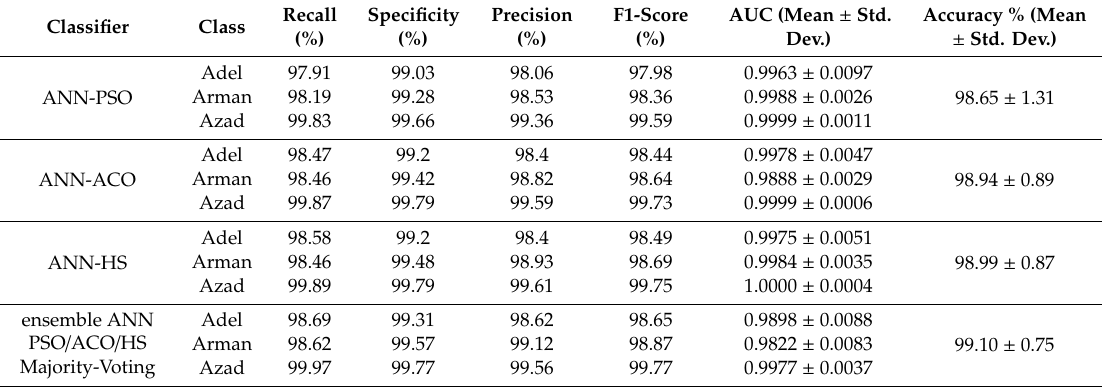
Table 9. Comparison of the performance of the four classifiers (ANN-PSO, ANN-ACO, ANN-HS and ensemble ANN PSO / ACO / HS-MV): recall, specificity, precision, f1-score, AUC and accuracy (1000 iterations, test